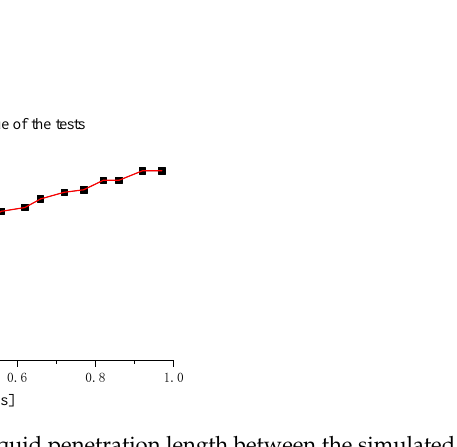
Figure 10. Comparison of liquid penetration length between the simulated and experimental results.